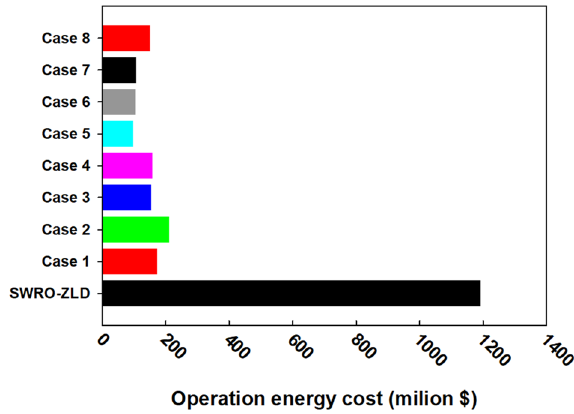
Fig. 5 Energy cost of two-stage SWRO with ZLD (brine concen- trator-crystallizer) and FO-based desalination process (brine circulation process, no brine discharge). ZLD plant capacity = 40,000 m 3 /day (two-stage SWRO process recovery rate = 60%), energy consumption by brine concentrator = 19.8 kWh/m 3 (recov- ery rate = 80%), and crystallizer = 56.8 kWh/m 3 (recovery rate =